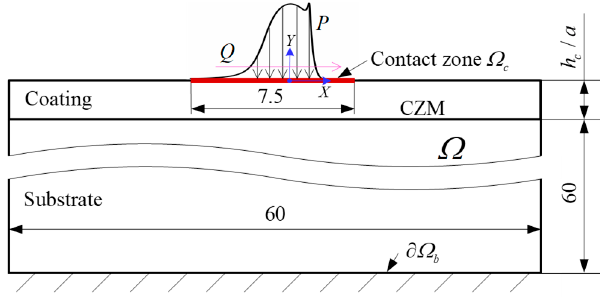
Figure 3. Computational domain of the EHL model for coated surfaces in a line contact.